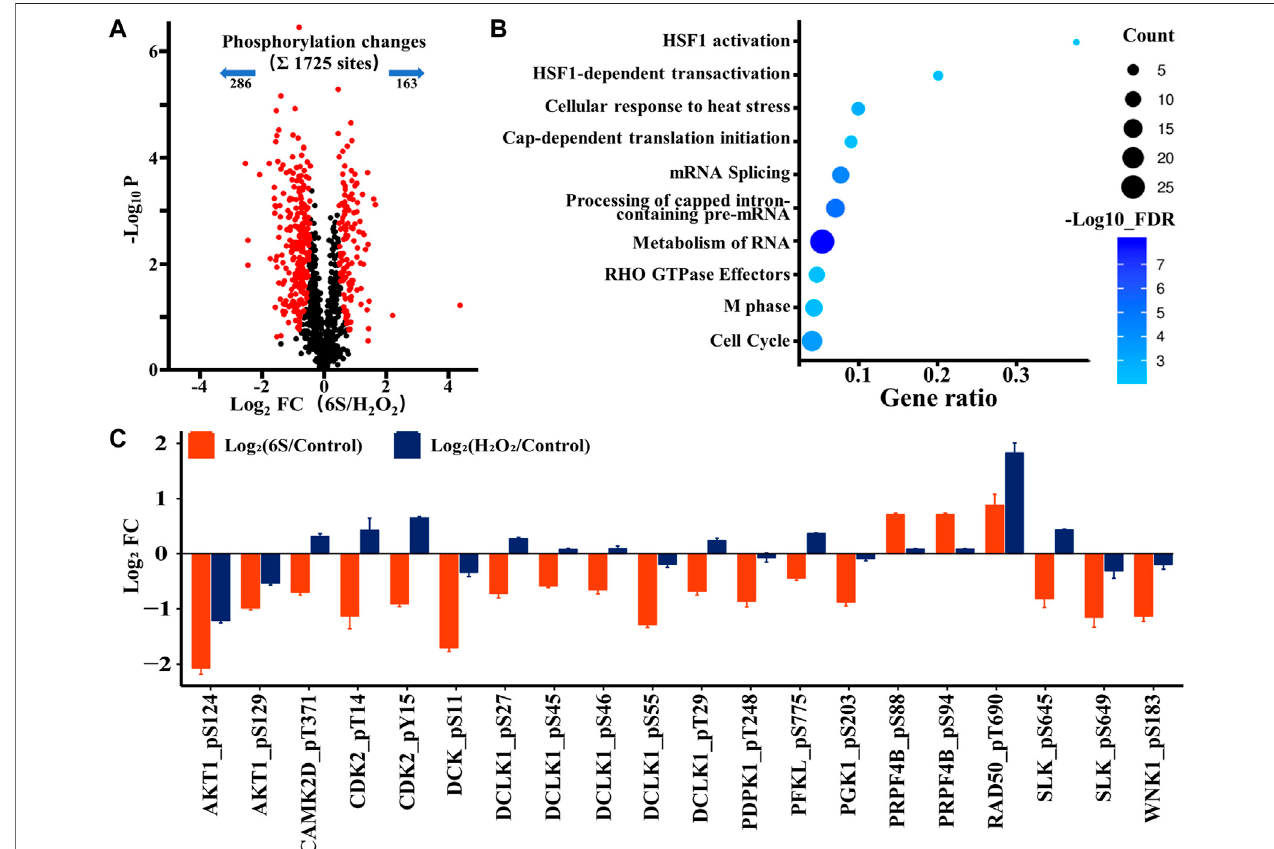
FIGURE 5 | Phosphoproteomic analysis of the action mechanism of 6S protection in VSMCs. (A) A volcano plot showed that 449 localized phosphorylation sites changed signi fi cantly (FDR < 0.05, S0 of 0.5) with pre-treatment of 6S compared with the control group upon H 2 O 2 treatment. (B) The Gene Ontology- (GO-) based Reactomepathwaysenrichmentofthealteredphosphoproteins. (C) Barplotsdisplaytheaveragelog2FC(FC:foldchange)ofquanti fi edsitesintheproteinkinasesthat differently expressed with pre-treatment of 6S compared with the control group upon H 2 O 2